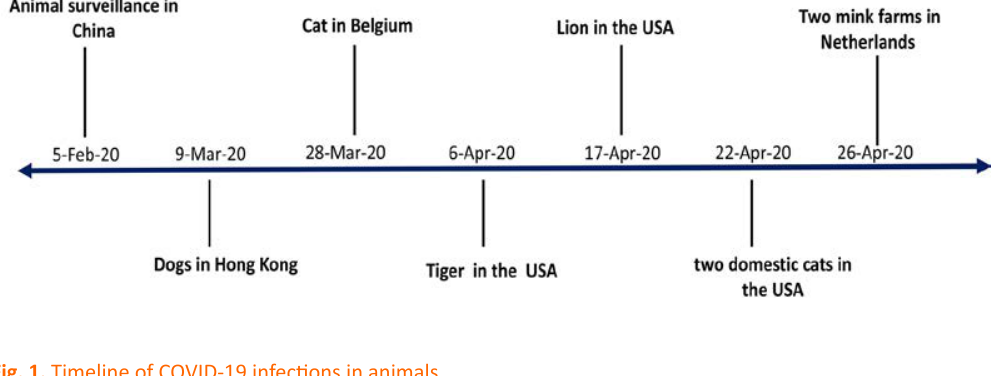
Fig. 1. Timeline of COVID-19 infections in